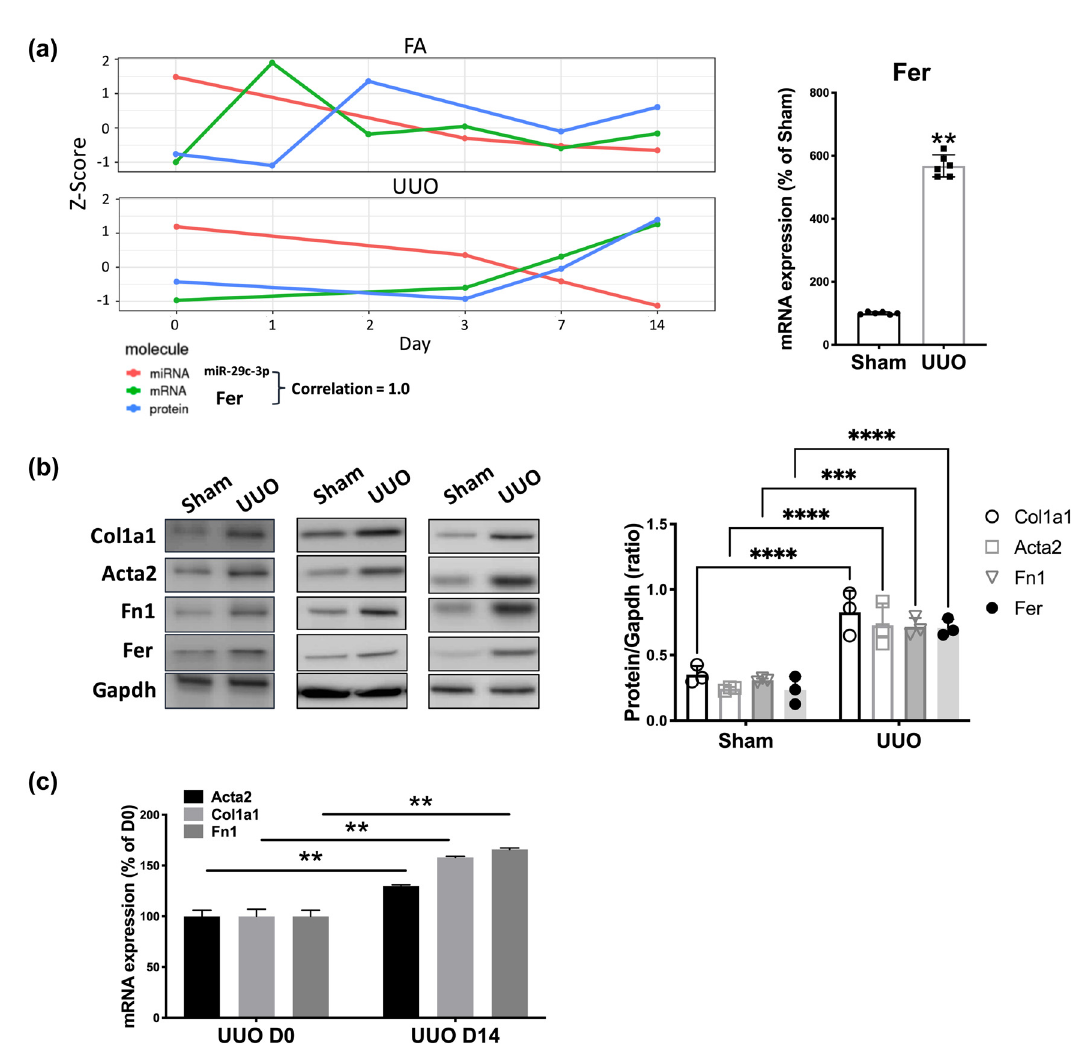
Figure 1: Pairs of Fer and miR - 29c are dysregulated in UUO - induced RF. ( a ) Reproduced from the Mouse Kidney FibrOmics online database, changes in miR - 29c expression and Fer expression/protein level over the 14 - day course in the FA - and the unilateral ureteral obstruction ( UUO )- induced RF mouse model on the left panel, and in vivo validation of Fer expression in kidneys harvested on day 14 post - op from mice ( N = 6 per group ) undergoing either sham surgery or UUO modeling. ( b ) Protein and ( c ) mRNA levels of fi brosis markers and Fer in kidneys harvested on day 14 post - op from mice ( N = 6 per group ) undergoing either sham surgery or UUO modeling ( * P < 0.05; ** P < 0.01 )